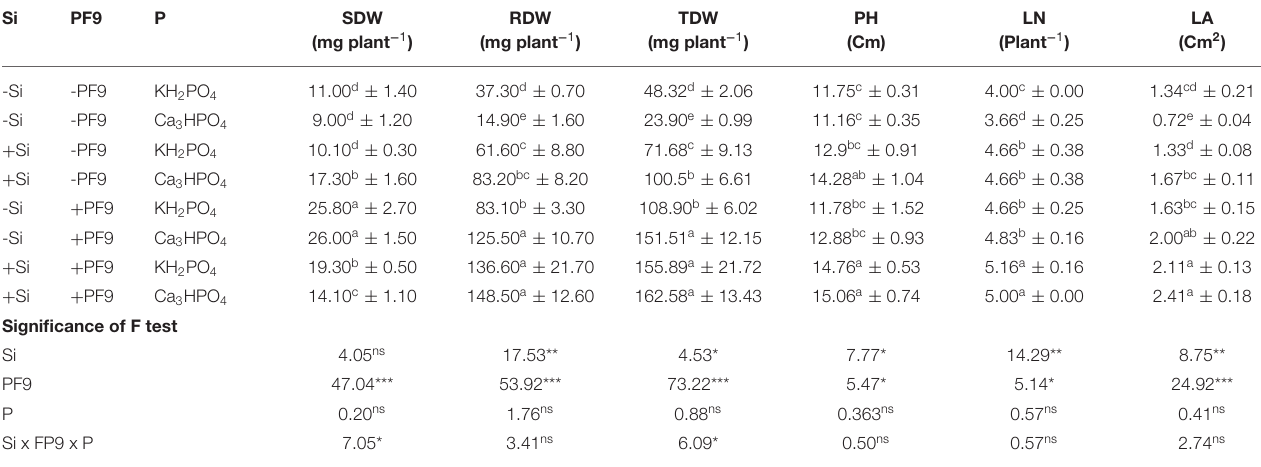
TABLE 1 | Effect of 3mM Si treatment, PF9 strain inoculation, and their combination on SDW, RDW, TDW, PH, LN, and LA of Medicago sativa ( OL population) plants grown under 250 µ mol of soluble (KH 2 PO 4 ) or insoluble (Ca 3 HPO 4 ) phosphorus conditions.